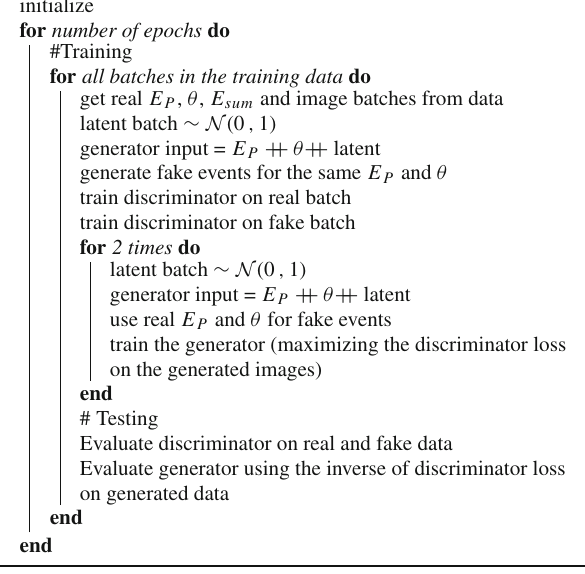
Fig. 4 The 3DGAN architecture, see the text for details